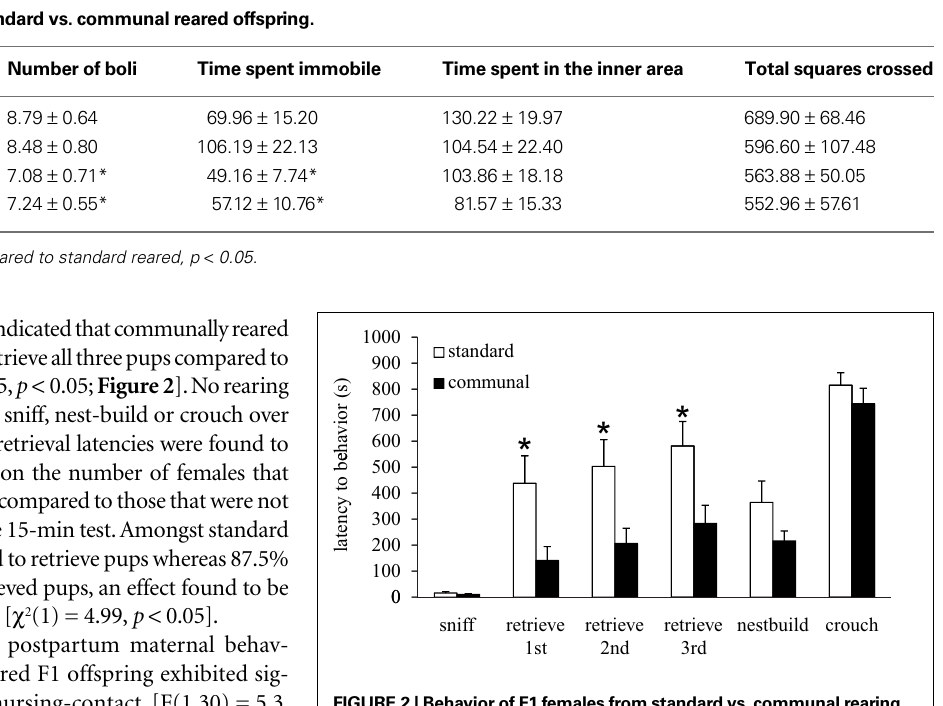
FIGURE 2 | Behavior of F1 females from standard vs. communal rearing conditions during a test of pup retrieval. Latency to retrieve all three pups and return them to the nest was shorter amongst communally reared F1